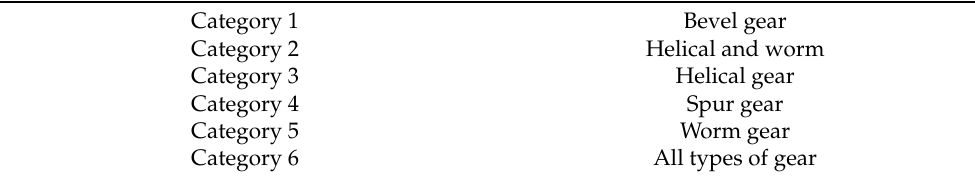
Table 2. Various types of gear manufacturing.